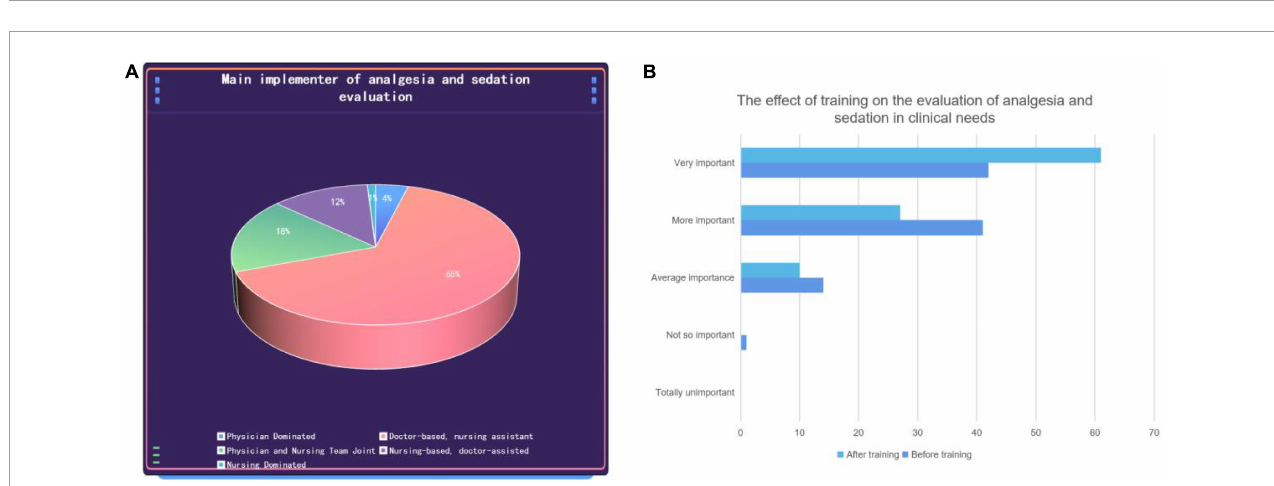
FIGURE3 The impact of training on the assessment of analgesia and sedation on the theory and practice of medical staff. (A) Clinical practice of analgesia and sedation evaluation. (B) The effect of training on the doctor’s evaluation of analgesia and sedation before and after